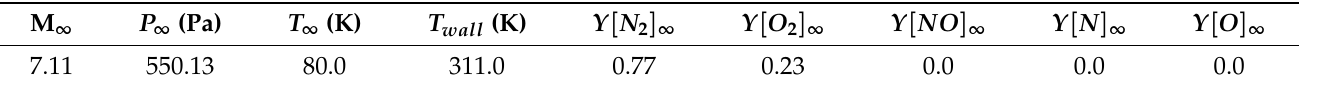
Table 6. ASWBLI free-stream conditions.